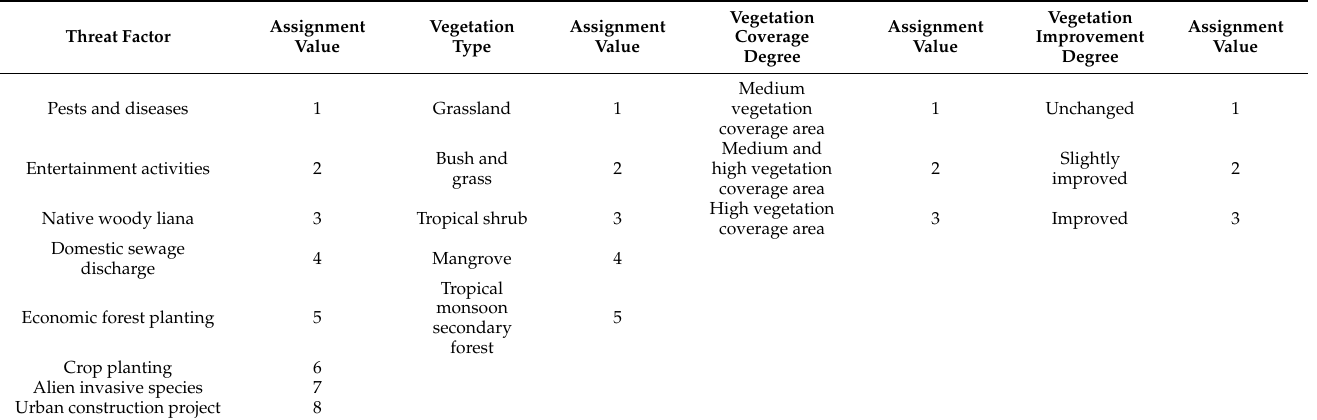
Table 1. Assignment values of different influencing factors.